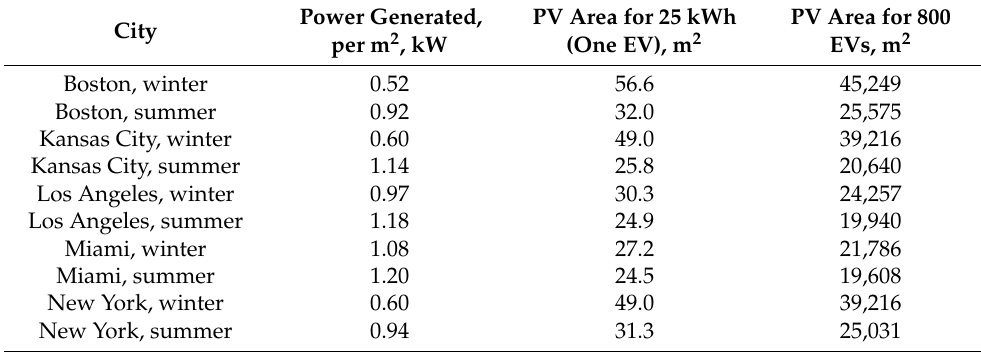
Table 2. Area required for increasing the charge of EV batteries by 25 kWh with PV cells. Power Generated, City per m 2 , kW